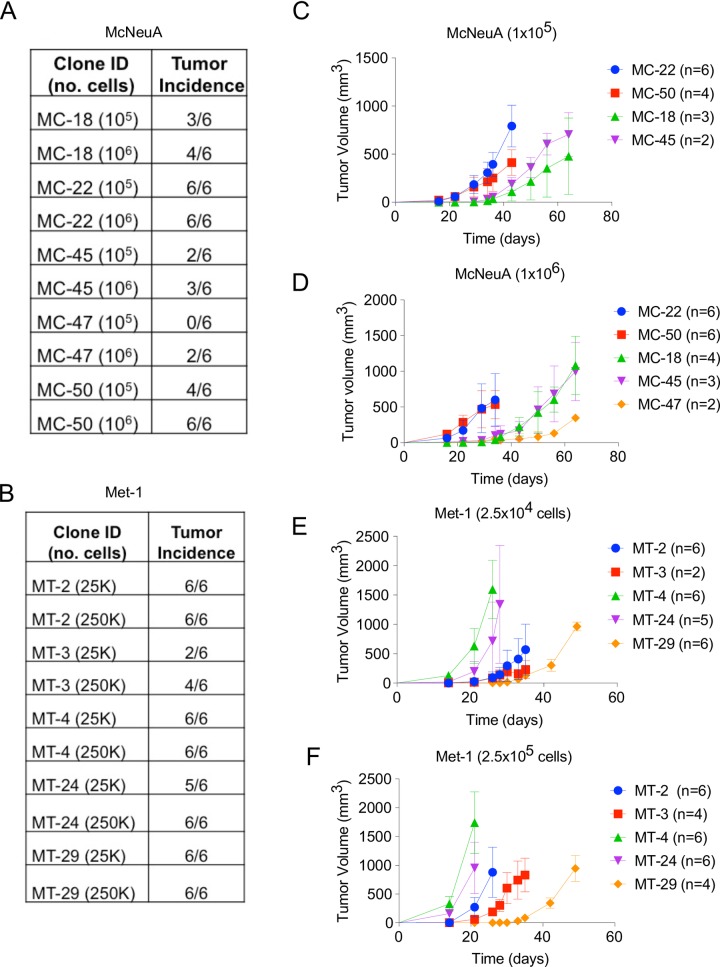
McNeuA and Met-1 subclonal populations are functionally heterogeneous in tumor incidence, latency and growth kinetics.(A,B) Primary tumor incidence of indicated McNeuA (105 or 106 cells; A) and Met-1 (2.5x104 or 2.5x105 cells; B) clonal populations that were injected orthotopically into FVB mice. (C,D) Tumor growth kinetics of indicated McNeuA clones that were orthotopically injected into FVB mice at 105 (C) or 106 (D) cells. Error bars represent SD; statistical significance evaluated using 2way-ANOVA. (E,F) Tumor growth kinetics of indicated Met-1 clones that were orthotopically injected into FVB mice at 2.5x104 (E) or 2.5x105 (F) cells. Error bars represent SD; statistical significance evaluated using 2way-ANOVA.